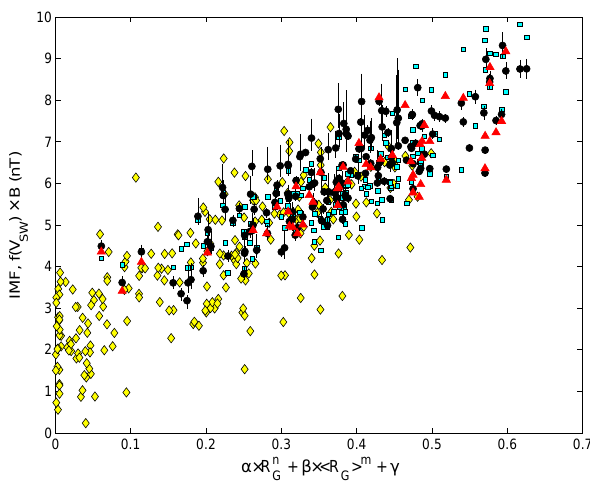
Fig. 10. A modified version of Fig. 9 with f (V SW )B shown as a m + β × < R + γ (where R function of B p = α × R n G > G is the G 11 simultaneous annual mean group sunspot number and < R G > 11 is the mean value over the preceding 11yr) with best-fit coefficients α = 0 . 462, n = 0 . 454, β = 0 . 090, m = 0 . 668 and γ = 0 . 006. The factor f (V SW ) allows for the effect on IMF B of the solar wind speed V SW using Eq. (2), based on Parker’s spiral